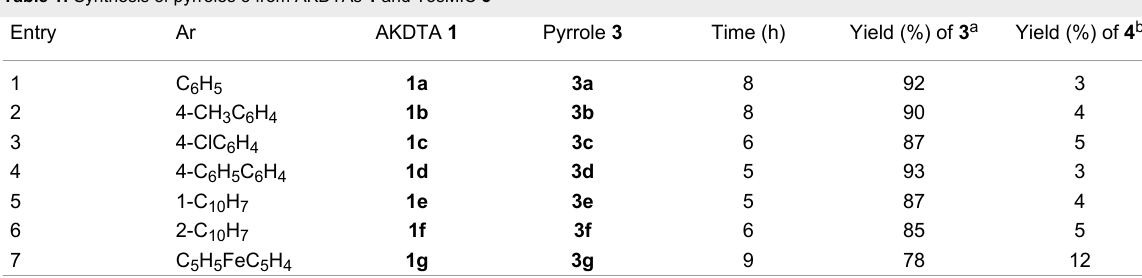
Table 1: Synthesis of pyrroles 3 from AKDTAs 1 and TosMIC